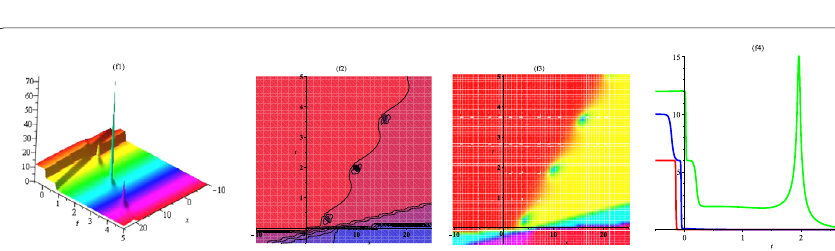
Figure 10 Diagram of 3-lump (2.20) by taking a = 1.5, b = 1, c = 2, d = 3, k 1 = 1, k 2 = 2, k 3 = 3, α = 0.1, (cid:14) = –1, τ = 2, η 10 = η 20 = η 30 = 0, R = 2, y = –2, at space (red x = –1, blue x = 0, and green x = 1)